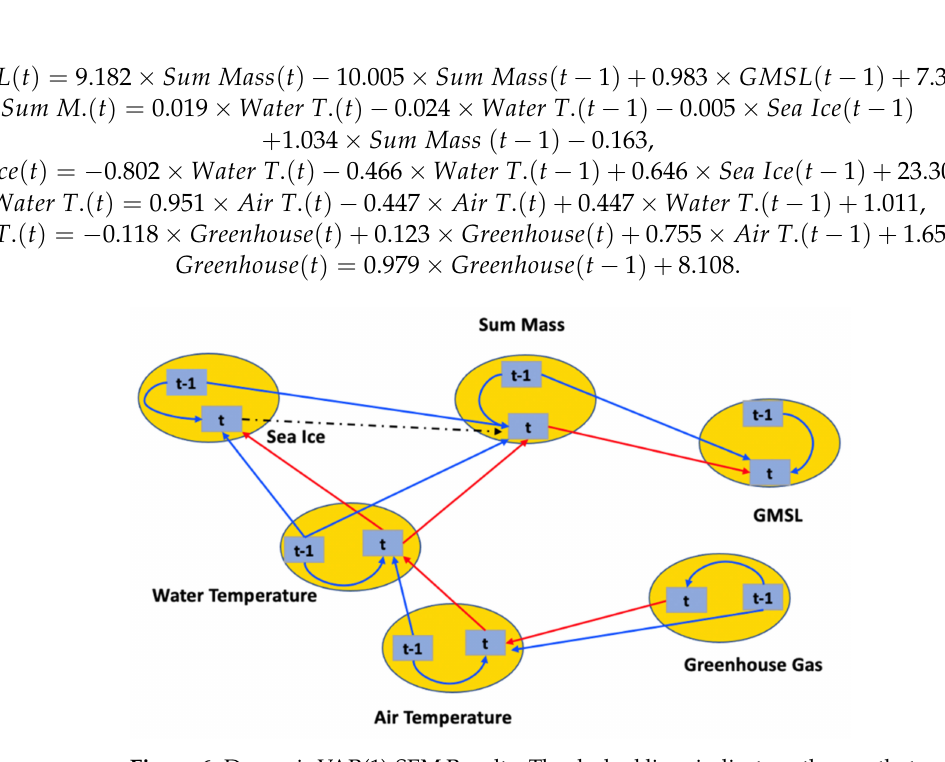
Figure 6. Dynamic VAR(1)-SEM Results: The dashed lines indicate pathways that were not significant. Solid blue lines indicate a significant longitudinal path from t − 1 to t , while solid red lines indicate a significant contemporaneous path from t to t . Table 2. VAR(1)-SEM